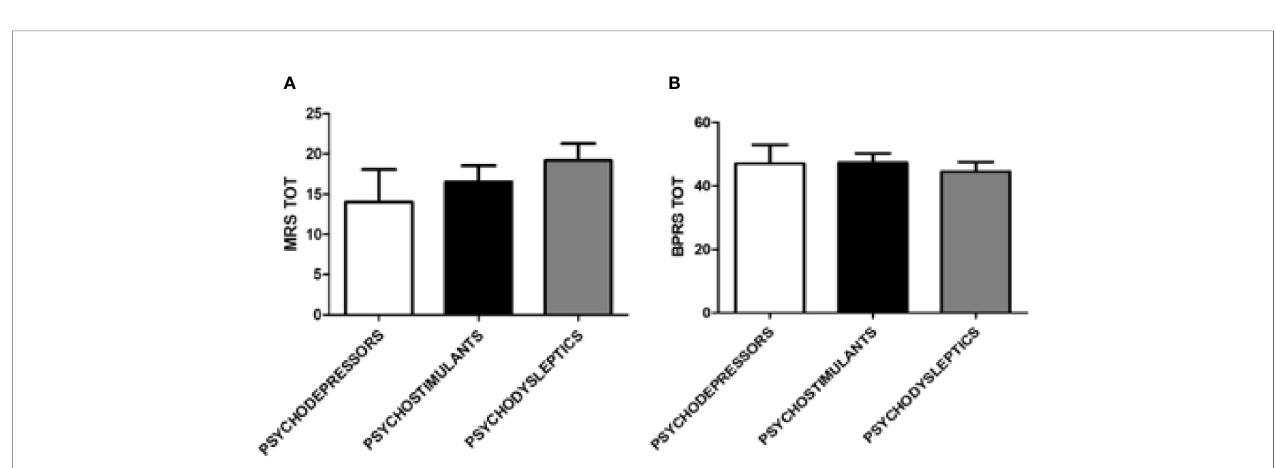
FIGURE 5 | Mania Rating Scale (MRS) and Brief Psychiatric Rating Scale (BPRS) scores according to categories of substances. (A) MRS score according to the following categories of substances: psychodepressors, psychostimulants, and psychodyslpetics. (B) BPRS score according to the following categories of substances: psychodepressors, psychostimulants, and